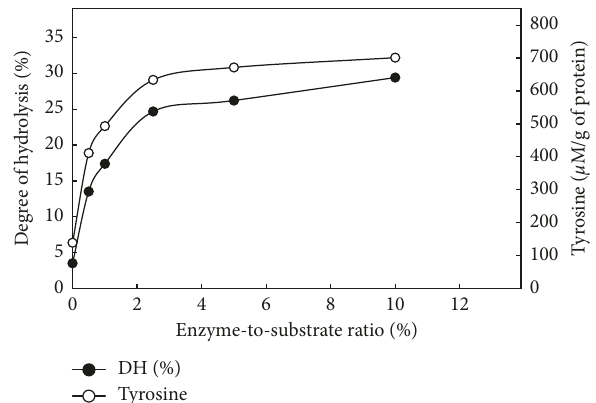
Figure 3: Hydrolysis of natural actomyosin (NAM) from the freshwater fish Catla catla using the papain enzyme at different enzyme-to-substrate ratios.